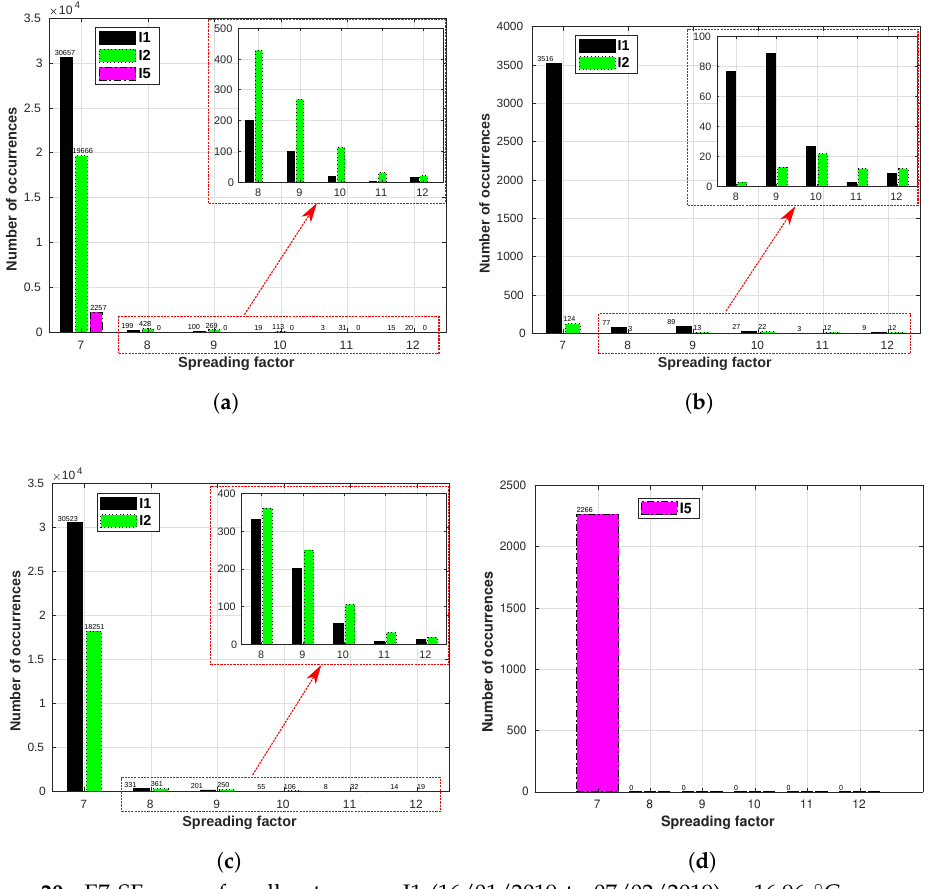
Figure 20. E7 SF usage for all gateways: I1 (16/01/2019 to 07/02/2019): − 16.96 ◦ C on average; I2 (22/12/2018 to 06/01/2019): − 9.45 ◦ C on average; I5 (15/05/2019 to 22/05/2019): 13.22 ◦ C on average. ( a ) E7 SF usage for GW1. ( b ) E7 SF usage for GW2. ( c ) E7 SF usage for GW3. ( d ) E7 SF usage for